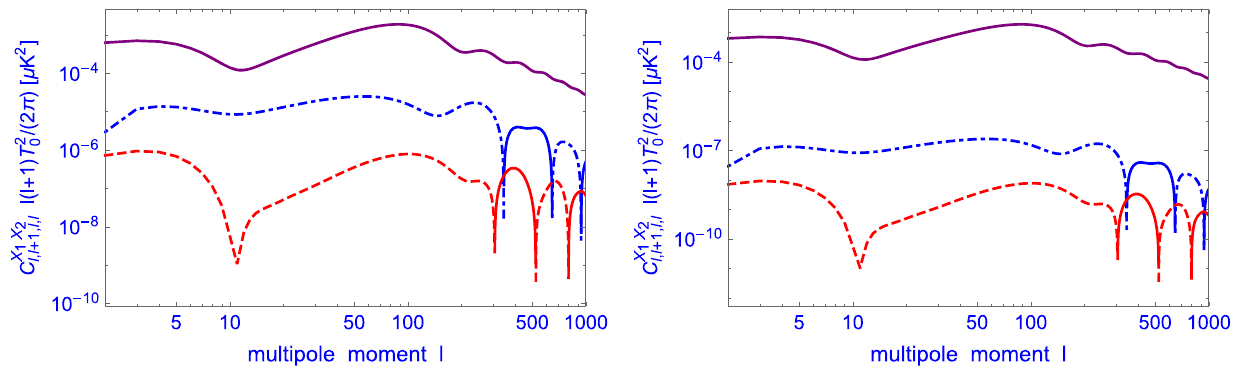
Fig. 3 The magnitude of T B spectrum C TB (the middle blue right hand side figures correspond to the canonical model with c s = 1 l , l + 1 , l , l and the non-canonical model with c s = 0 . 1, respectively. Note again dashed-solid curve) and the magnitude of EB spectrum C EB (the l , l + 1 , l , l that the dotted-dashed (blue) and dashed (red) curves also denote the bottom red dotted-solid curve), both induced by the cross-correlations, < 0 region where C X 1 X 2 are shown in comparison with the magnitude of the isotropic BB spec- l , l + 1 , l , l trum C BB (the upper purple dotted curve). The left hand side and l , l , 0 , 0